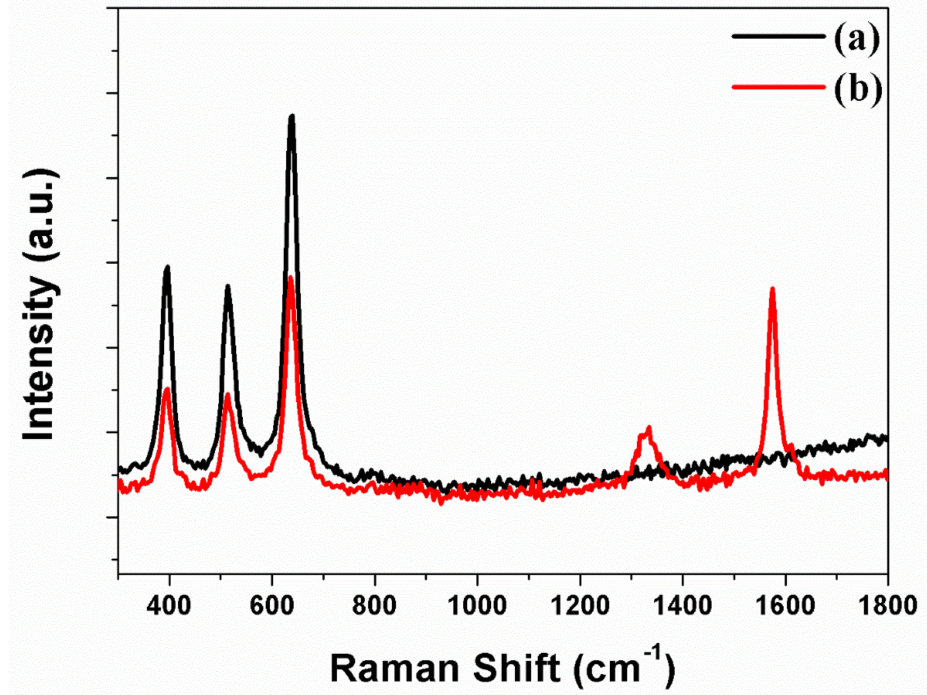
Figure5. RamanspectraoffreestandingTNTAs( a )withoutcarbonmaterialsand( b